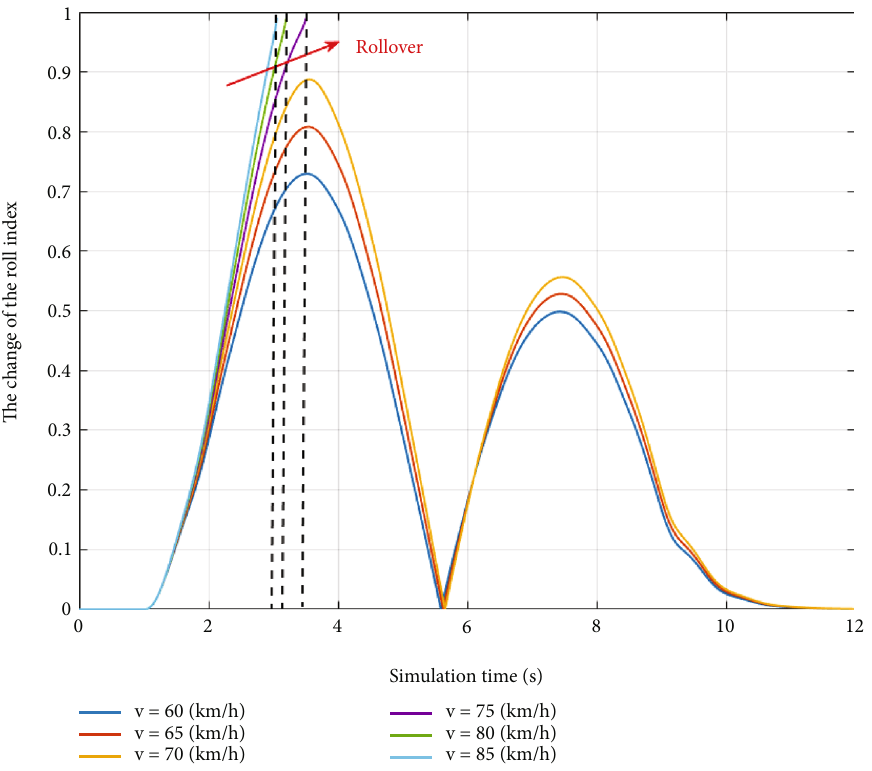
Figure 13: The change of the roll index (the third case — velocity